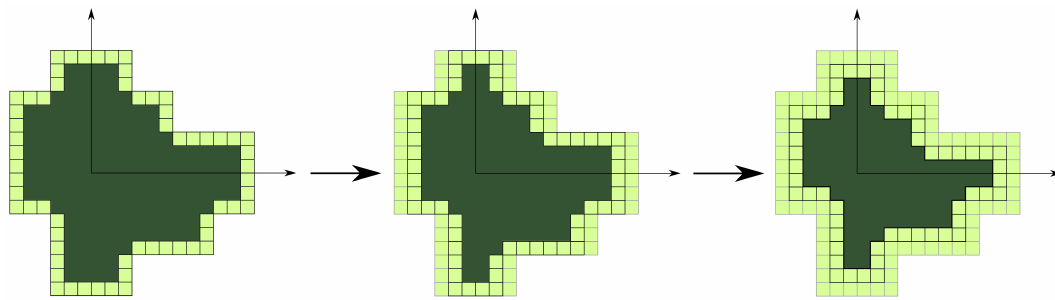
Figure A4. Extension of a crown edge towards the tree trunk. The extension is conducted in two consecutive steps, namely in the x and the y directions. Light green represents voxels contained in tree crown envelope, and dark green represents inside of the